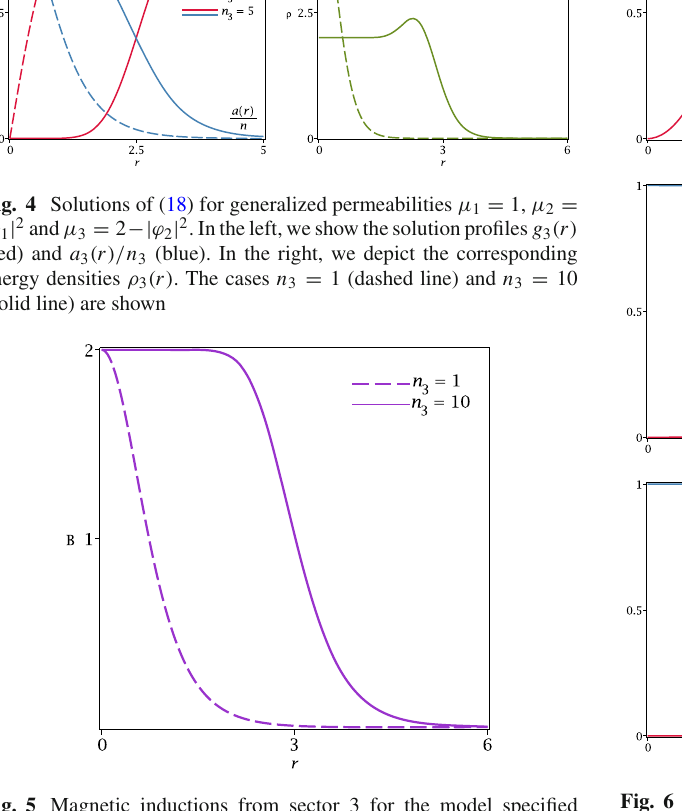
= 2, n = 8 , n = 10 1 2 3